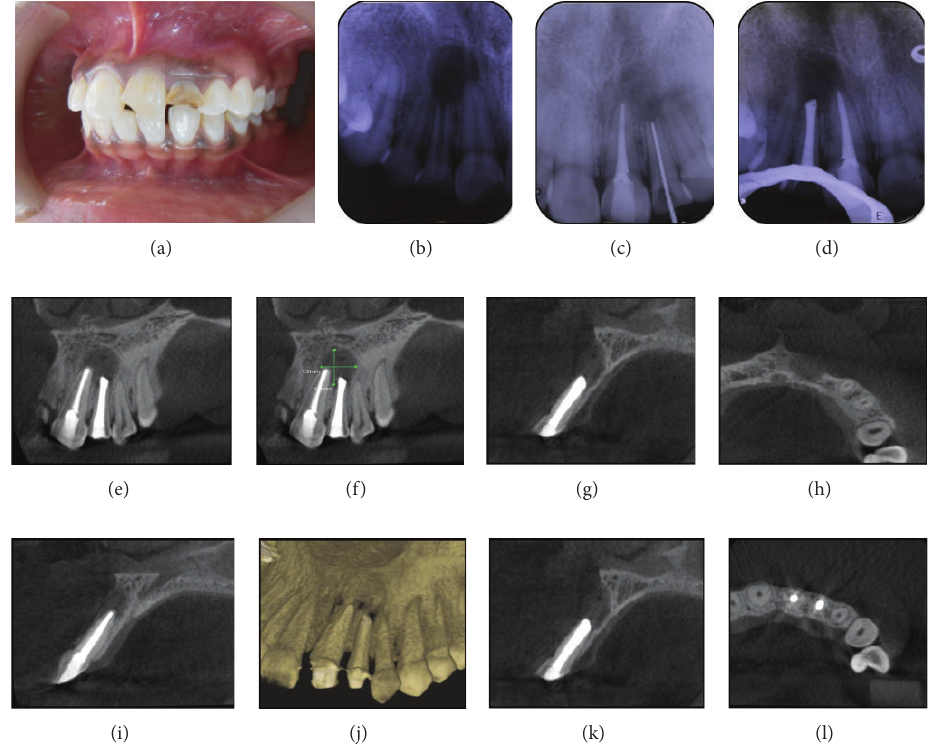
Figure 1: (a) Preoperative photo showing crown fracture and discoloration in left maxillary lateral incisor. (b) IOPA radiograph showing well- defined radiolucency and open apex. (c) Working length IOPA radiograph. (d) IOPA radiograph showing MTA obturation. (e) Coronal plane CBCT image showing size of periapical lesion immediately after MTA obturation. (f) Coronal plane CBCT image showing size of periapical lesion; dimensions 9.8 mm/7.5mm. (g) Sagittal plane CBCT image showing size of periapical lesion immediately after MTA obturation. (h) Axial plane CBCT image showing size of periapical lesion immediately after MTA obturation. (i) Sagittal plane CBCT image showing size of periapical lesion immediately after endodontic treatment in tooth 21. (j) Three-dimensional CBCT image of periapical lesion immediately after MTA obturation. (k) Sagittal plane CBCT image showing status of MTA obturation. (l) Axial plane CBCT image showing status of MTA obturation.